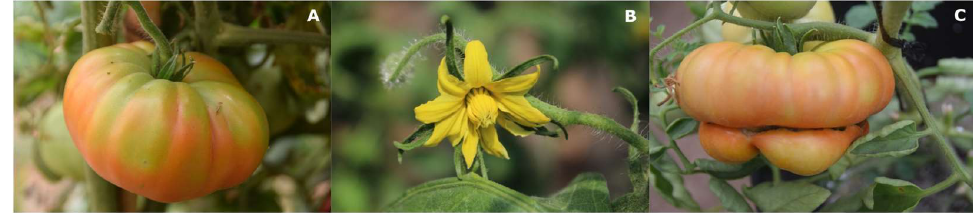
Figure 13. Different outcomes of Old Limachino Tomato plants: ( A ) fruit, ( B ) floret and ( C ) deformed fruit (or “Rosca”).